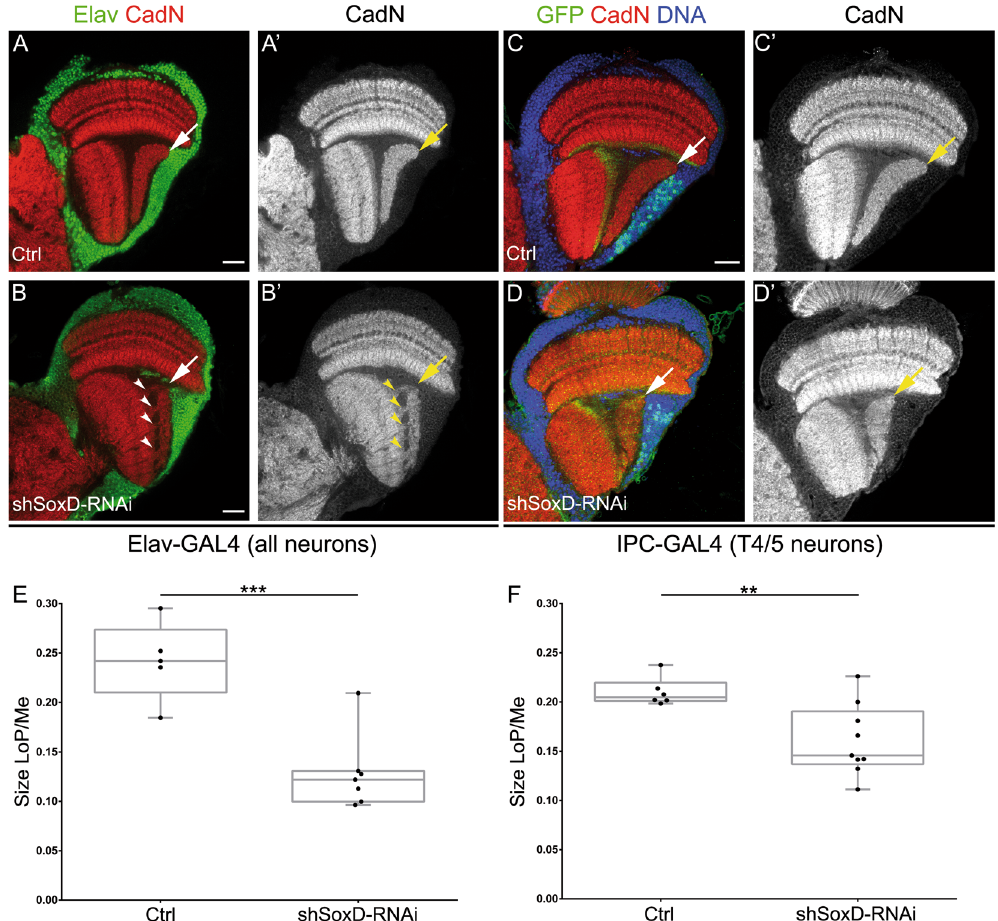
Figure 4. Lobula plate development requires SoxD function. ( A,B’ ) Immunostaining of ( A,A’ ) control and ( B,B ’) shSoxD-RNAi knockdown adult optic lobes against Elav (green) and CadN (red or gray). Knockdown was performed in all neurons during development using the Elav-GAL4 driver. ( C,C’ ) Immunostaining of control and ( D,D’ ) shSoxD-RNAi knockdown adult optic lobes using the IPC-Gal4 driver. Arrows indicate the lobula plate neuropil and arrowheads show bridges between the lobula and lobula plate neuropils. Scale bars are 20 µ m. ( E , F ) Graphs showing the quantifications of the lobula plate (LoP) size normalised to the size of the medulla (Me) of control and shSoxD-RNAi knockdown in ( E ) all neurons and ( F ) T4/T5 neurons. Student’s t-test was performed. ** and *** are p-value < 0.01 and 0.001